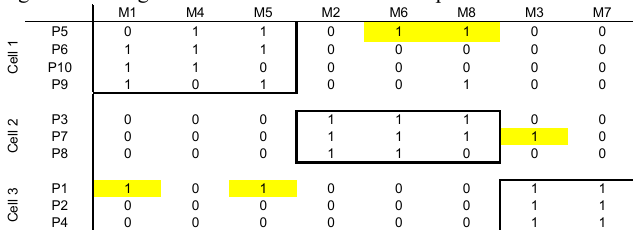
Figure 8. Configuration of cells in the first example M1